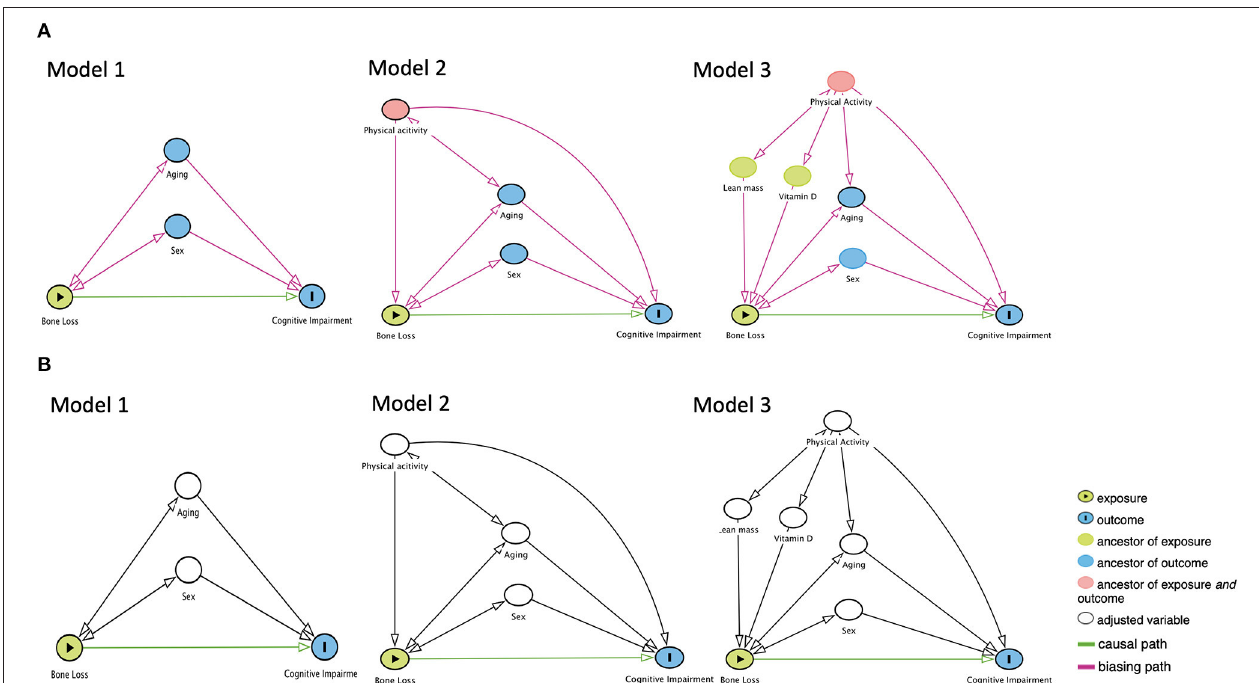
FIGURE 1 | The proposed directed acyclic graphs between bone loss and cognitive impairment. (A) Models of the no adjustment of confounders. (B) Models of the adjustment of confounders.